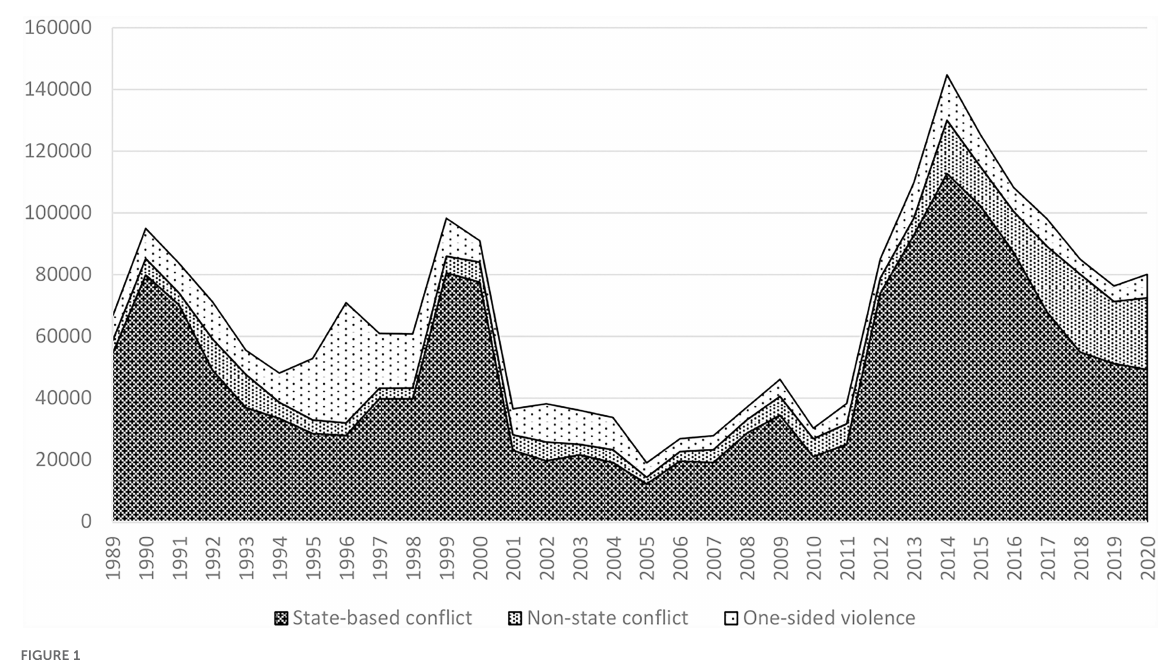
of World War II consisting mainly of conflicts about territory and government.